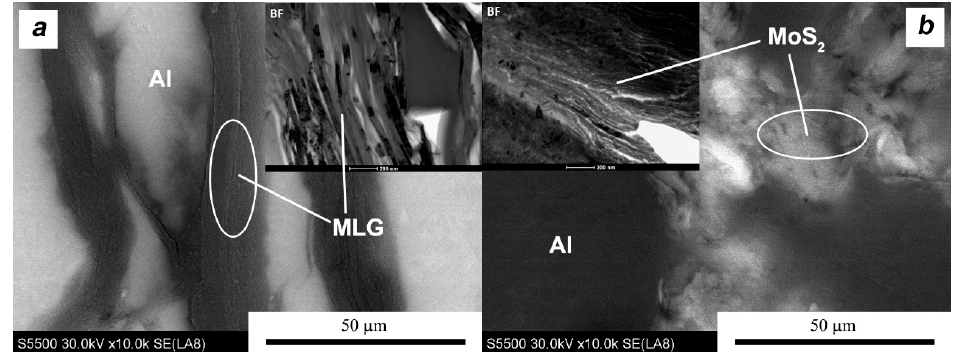
Figure 14. Microstructure of SPS composites, showing the arrangement of individual flakes at the borders between aluminum particles: ( a ) MLG and ( b ) MoS 2 .